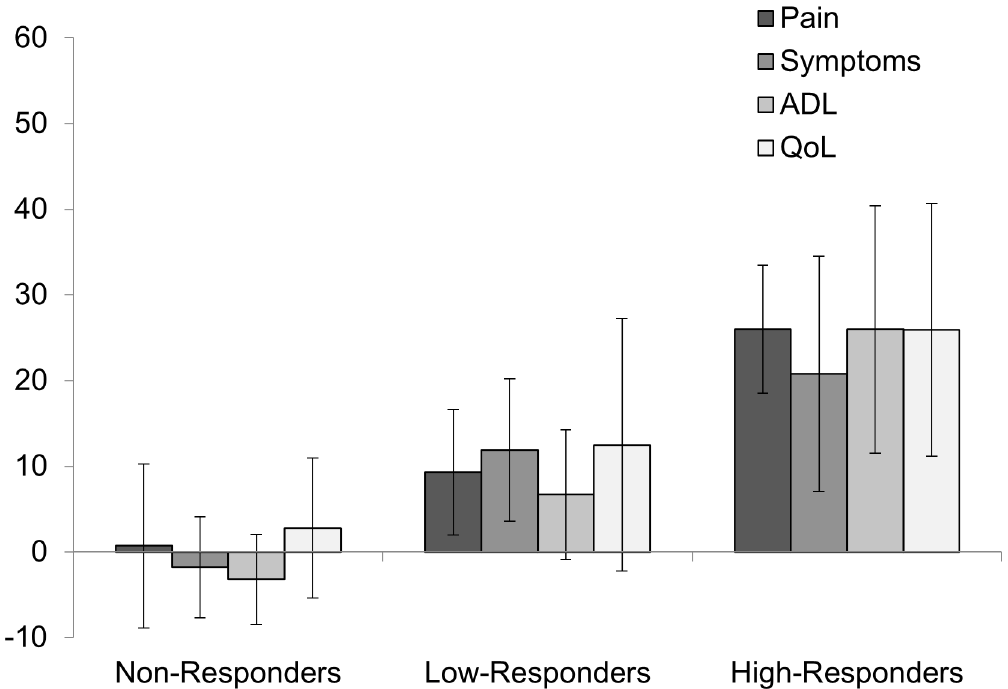
Fig 2. Absolute change in KOOS subscale scores following 6-week intervention, organized by subgroups. Abbreviations: ADL = Function in Daily Living; QoL = Knee Related Quality of Life. Note: KOOS is measured on a scale of 100, with 100 being best (e.g., no pain) and 0 being worst (e.g., most pain